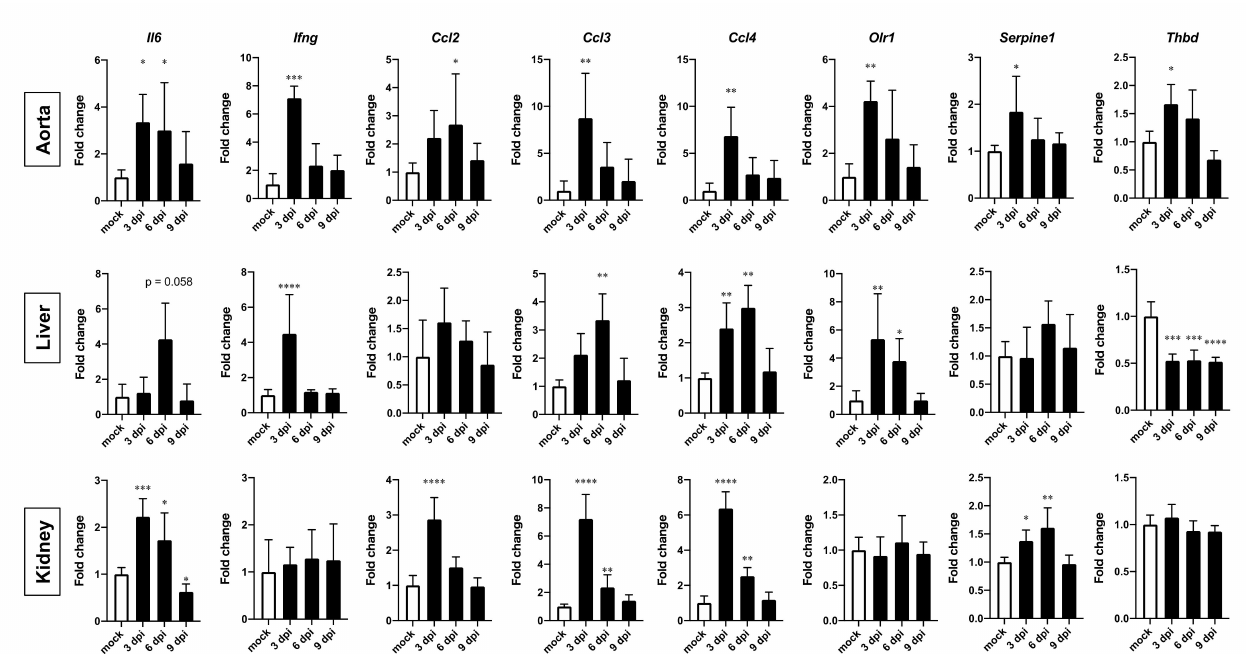
Figure 7. Gene expression of inflammation and coagulation factors in the aorta, liver, and kidneys of aged hamsters infected with CoV2. Aged (>36 w) hamsters were intranasally inoculated with PBS control (mock) or PBS containing SARS-CoV-2 virus (CoV2), and hamsters were euthanized at 3, 6, and 9 days post infection (dpi) for the collection of aorta, liver, and kidney samples for gene expression analyses. Gene expression levels of interleukin-6 ( Il6 ), interferon-gamma ( Ifng ), C-C motif chemokine 2 ( Ccl2 ), Ccl3 , Ccl4, oxidized low-density lipoprotein receptor 1 ( Olr1 ), serine protease inhibitor, clade E, member 1 ( Serpine1 ), and thrombomodulin-encoding Thbd are presented as the fold changes relative to those of mock hamsters. Bars represent the mean ± SEM ( n = 5). White and black bars indicate data from control and CoV2-infected hamsters, respectively. * p < 0.05, ** p < 0.01, *** p < 0.001, **** p < 0.0001, one-way ANOVA on dCt values with Dunnett’s multiple comparison test (vs. mock